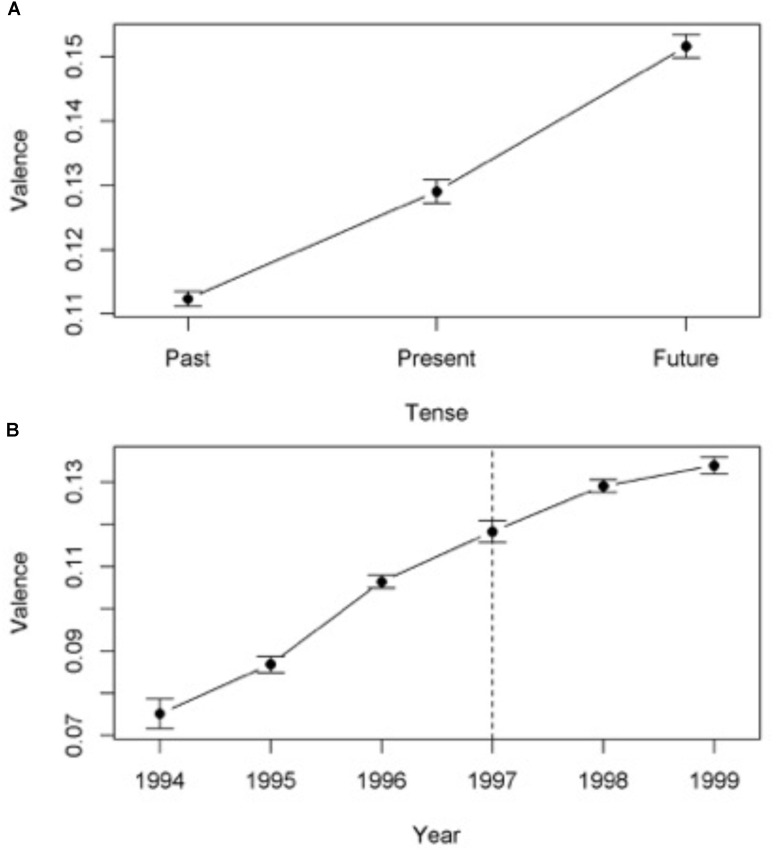
(A) Mean Valence and confidence intervals for Reuter Verbs in Past, Present, and Future tense. (B) Mean Valence and confidence intervals for Reuter Years. Dotted line marks the relative publication date.